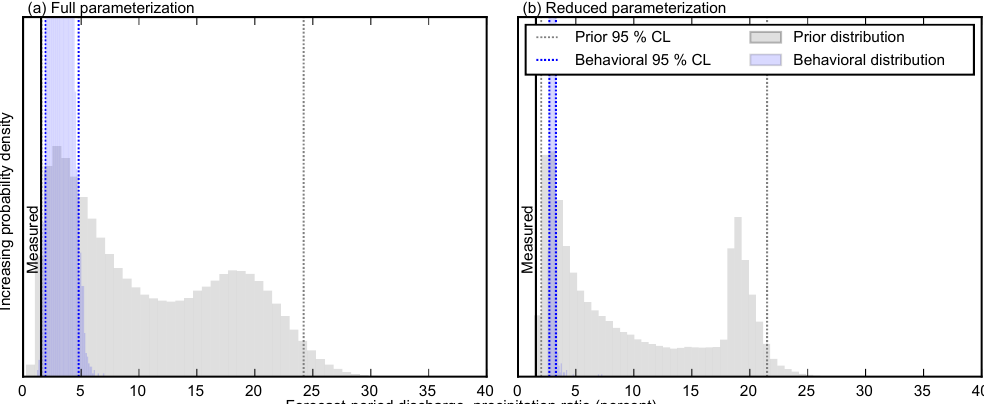
Figure 7. Quantity of interest QOI-4: simulated forecast period (posttreatment) streamflow as a percentage of precipitation. Both the param- eterizations appear to have been “overfit” with respect to this QOI, as neither behavioral distributions bracket the measured value at the 95% confidence